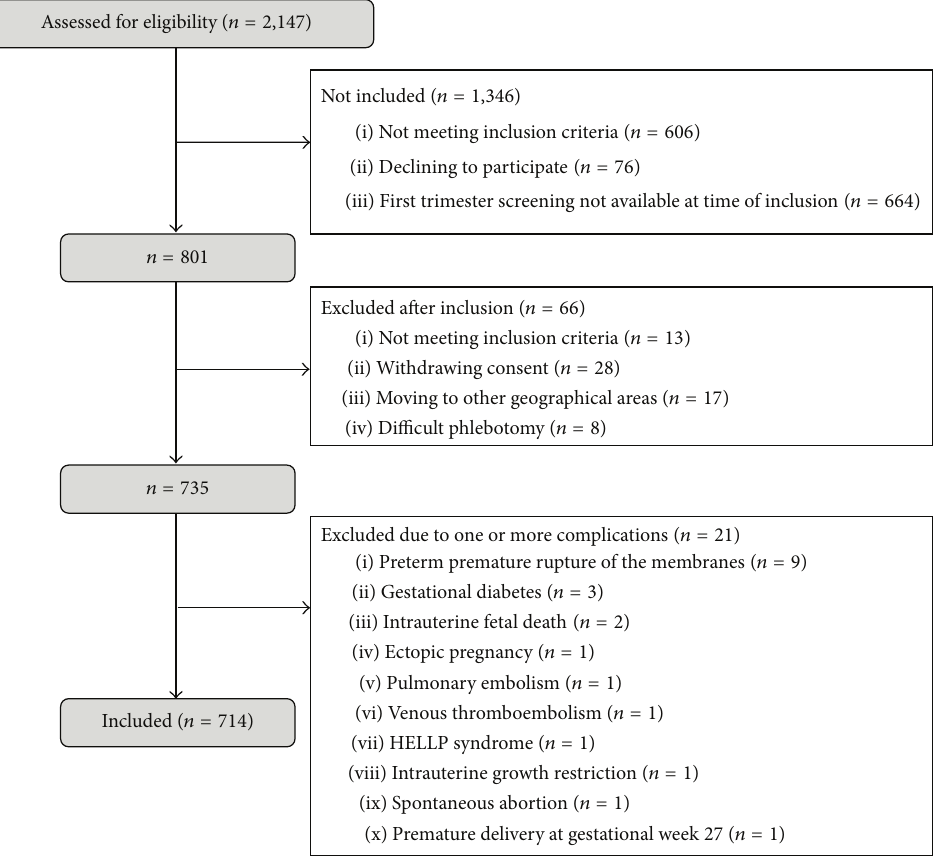
Figure 1: Consort flow